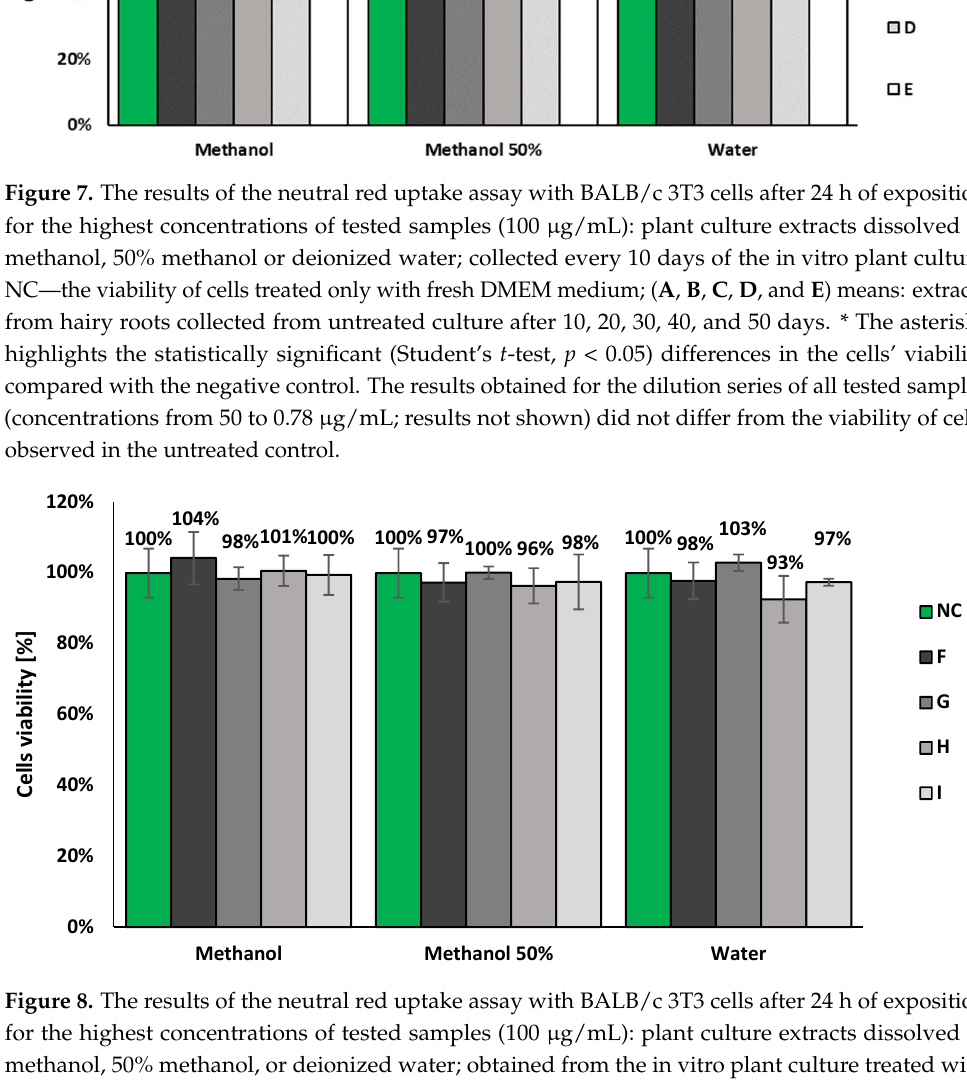
Figure 8. The results of the neutral red uptake assay with BALB/c 3T3 cells after 24 h of exposition for the highest concentrations of tested samples (100 µg/mL): plant culture extracts dissolved in methanol, 50% methanol, or deionized water; obtained from the in vitro plant culture treated with various elicitors. NC—the viability of cells treated only with fresh DMEM medium; ( F ) hairy roots elicited for 3 days with 50 µM MeJA; ( G ) hairy roots elicited for 7 days with 100 µM MeJA; ( H ) hairy roots elicited for 1 day with 100 µM MeJA 100 and then transferred to control medium for 30 day cultivation; ( I ) hairy roots elicited for 7 days with 100 µM MeJA 100 and then transferred to control medium for 30 day cultivation.